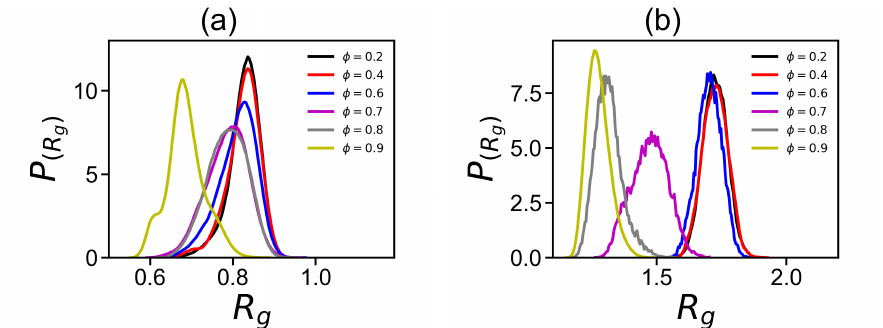
Figure 4. The distribution function P ( R g ) of the radius of gyration R g for ( a ) DGL1 and ( b ) DGL2 at different volume fractions of methanol φ in the methanol–water